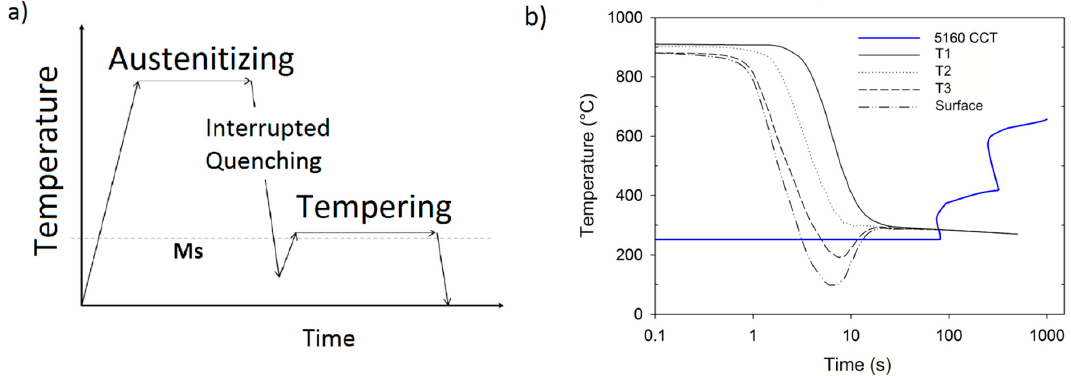
Figure 3. Schematic of the heat treatment cycle showing the interruption of quenching ( a ), and cooling curves at different locations ( b ).